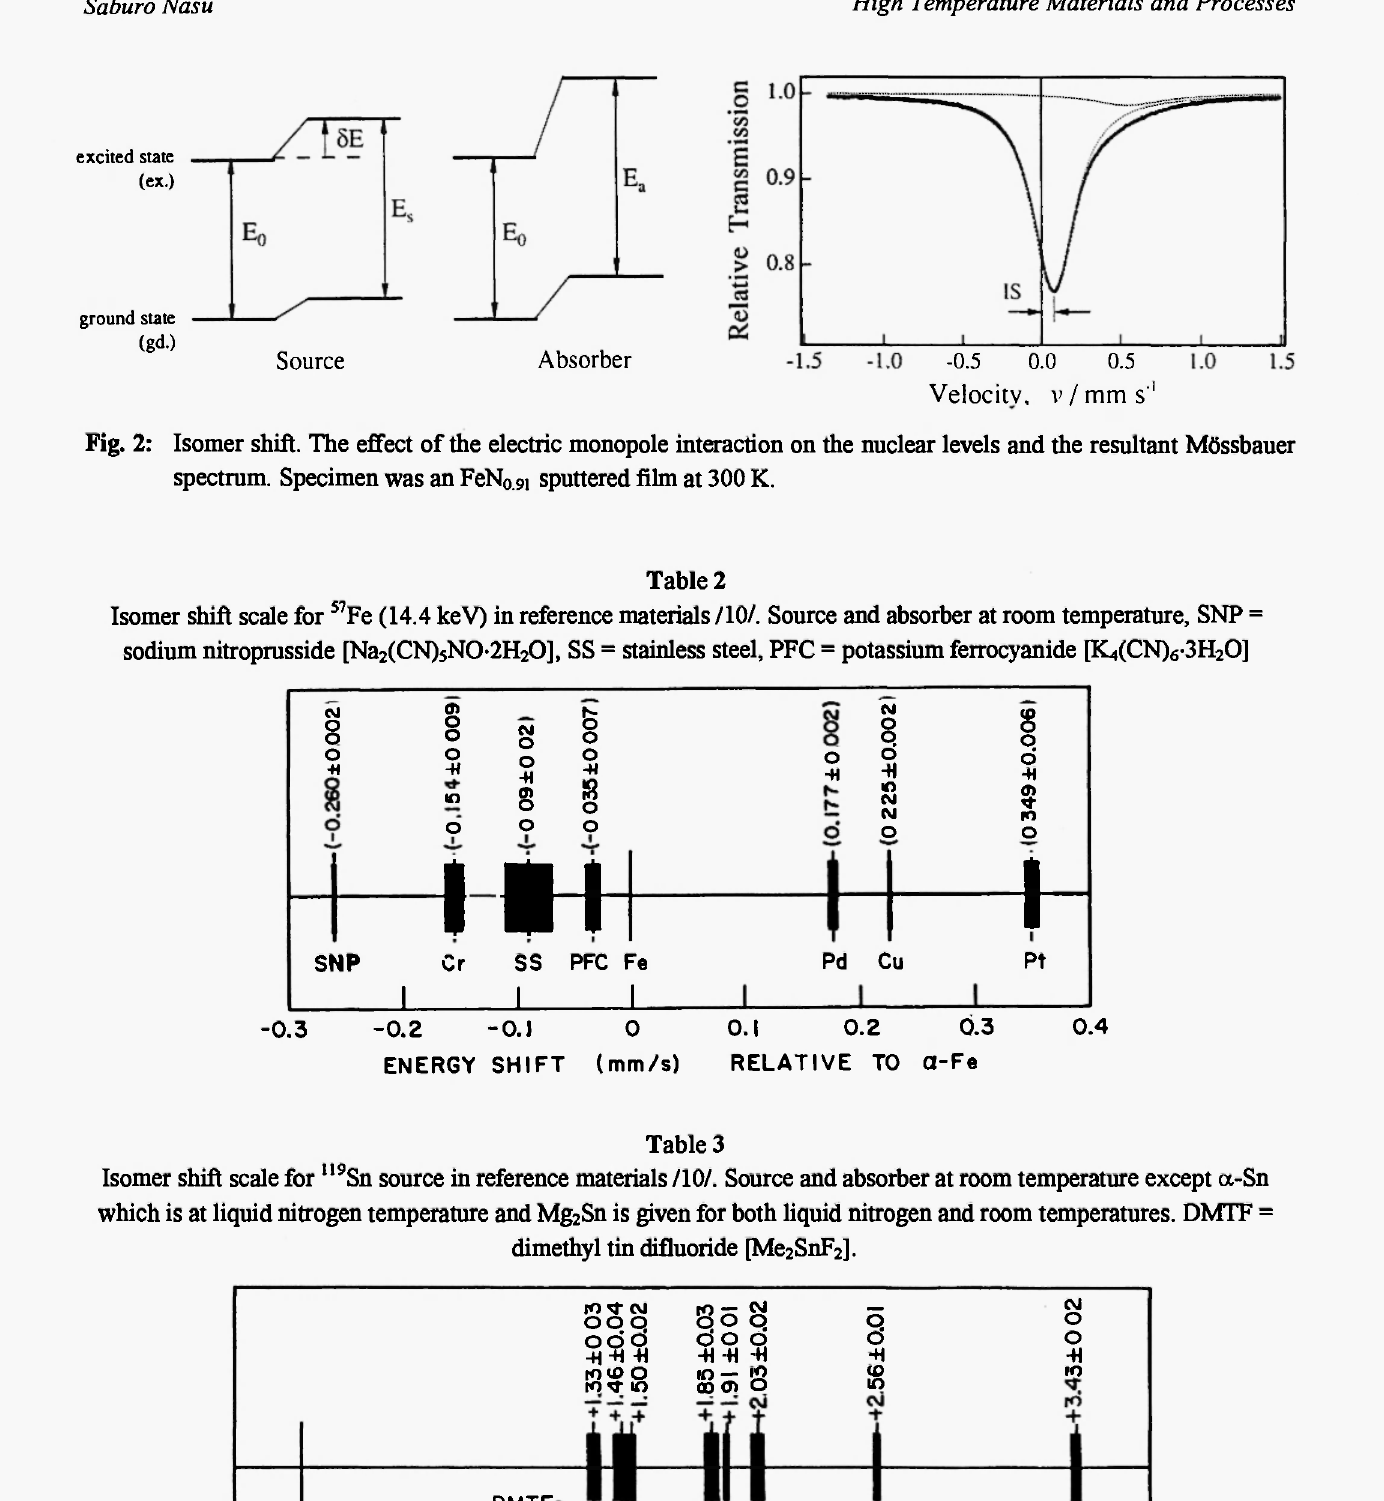
Isomer shift scale for 1I9 Sn source in reference materials /10/. Source and absorber at room temperature except a-Sn which is at liquid nitrogen temperature and Mg2Sn is given for both liquid nitrogen and room temperatures. DMTF